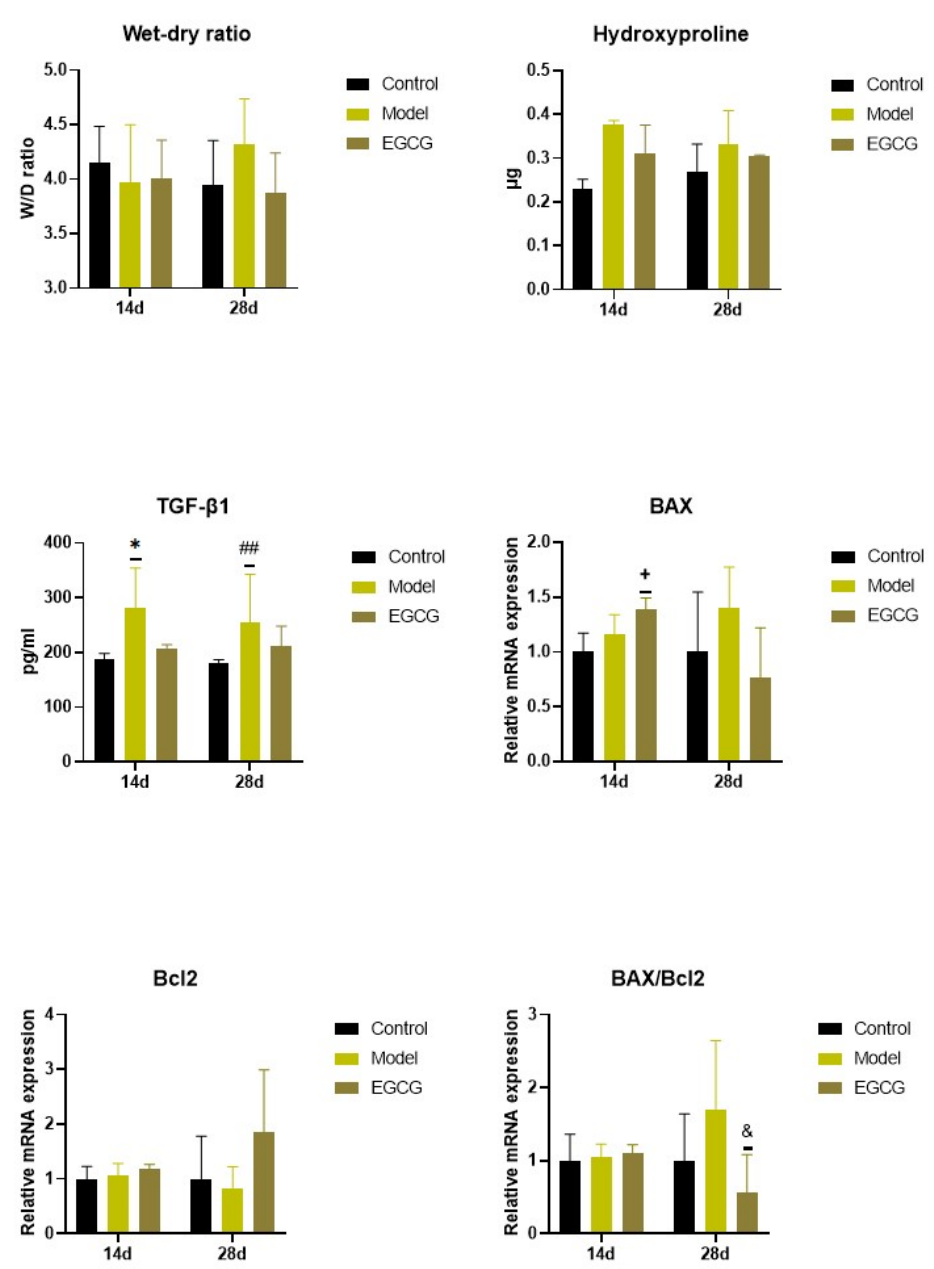
Figure 3. Changes in the W/D ratio and in the markers of apoptosis and fibrosis in the lungs of saline ‐ instilled animals (Control), silica ‐ instilled non ‐ treated animals (Model), and EGCG ‐ treated silica ‐ instilled animals (EGCG) after 14 days (14d) or 28 days (28d) of the treatment delivery. Abbreviations: TGF ‐β 1: transforming growth factor ‐ beta 1; Bcl ‐ 2: B ‐ cell lymphoma 2 protein; BAX: Bcl ‐ 2 associated X ‐ protein. For statistical differences among the groups: * p < 0.05 for Model14d vs. Control14d; + p < 0.05 for EGCG14d vs. Model14d; ## p < 0.01 for Model28d vs. Control28d; & p < 0.05 for EGCG28d vs. Model28d.